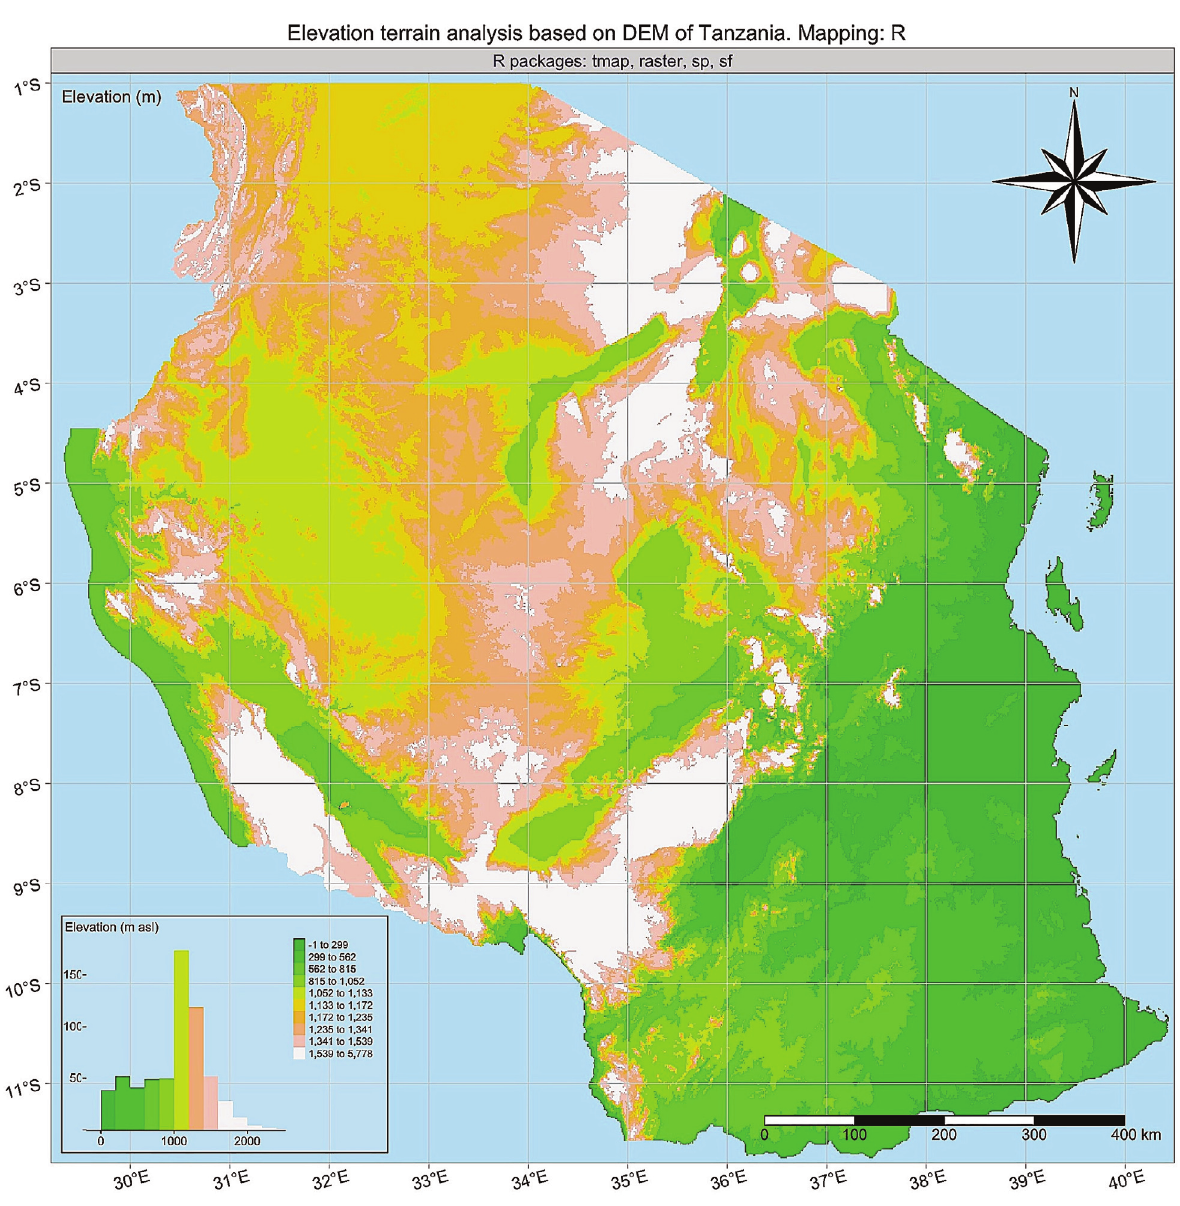
Fig. 6. Visualization of the Digital Elevation Model (DEM) of the terrain of Tanzania. Mapping by R using packages ‘tmap’, ‘raster’, ‘sp’, ‘sf’. Map source: elaborated by the